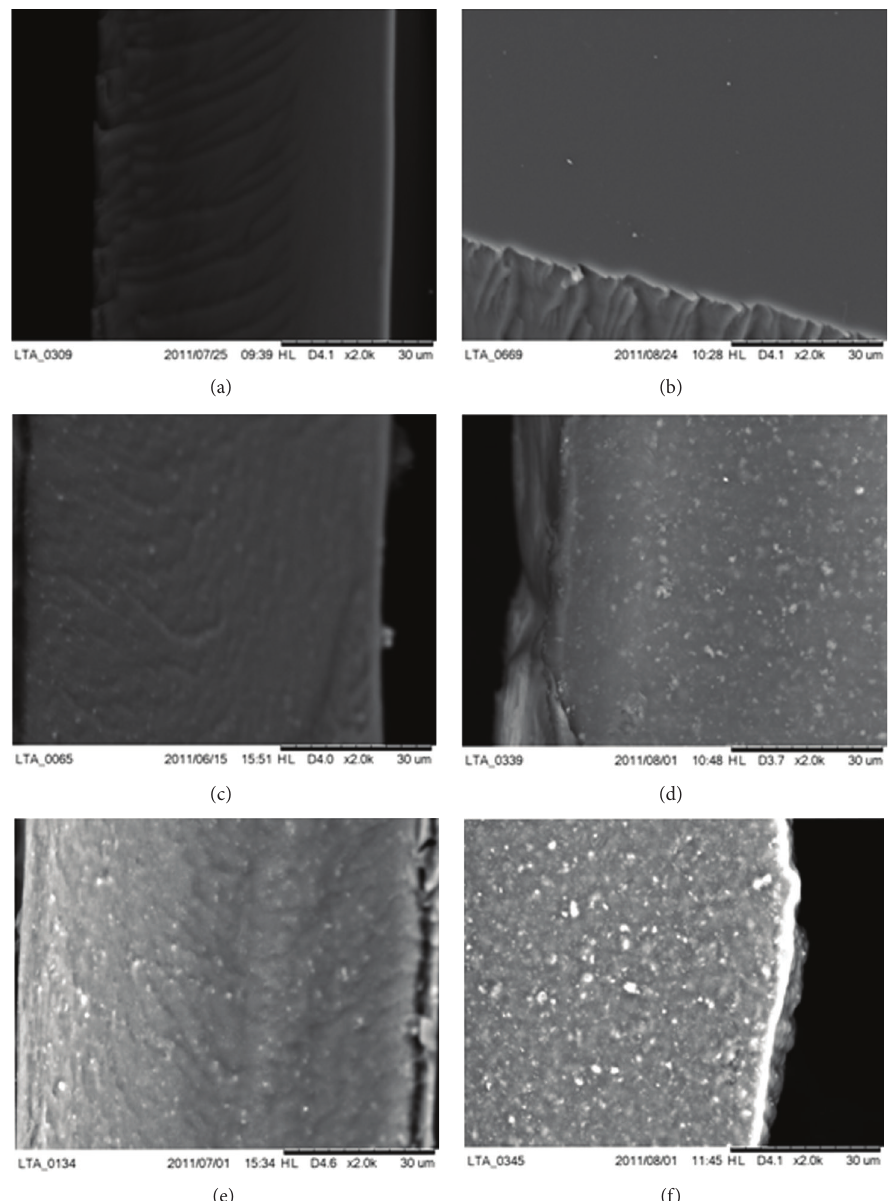
Figure 5: Scanning electron microscopy images of cryofractured longitudinal (left) and of the air-dried surface (right) of nanocomposites prepared with 5% of gelatin and 0% (top), 5% (center), and 10% (bottom) of